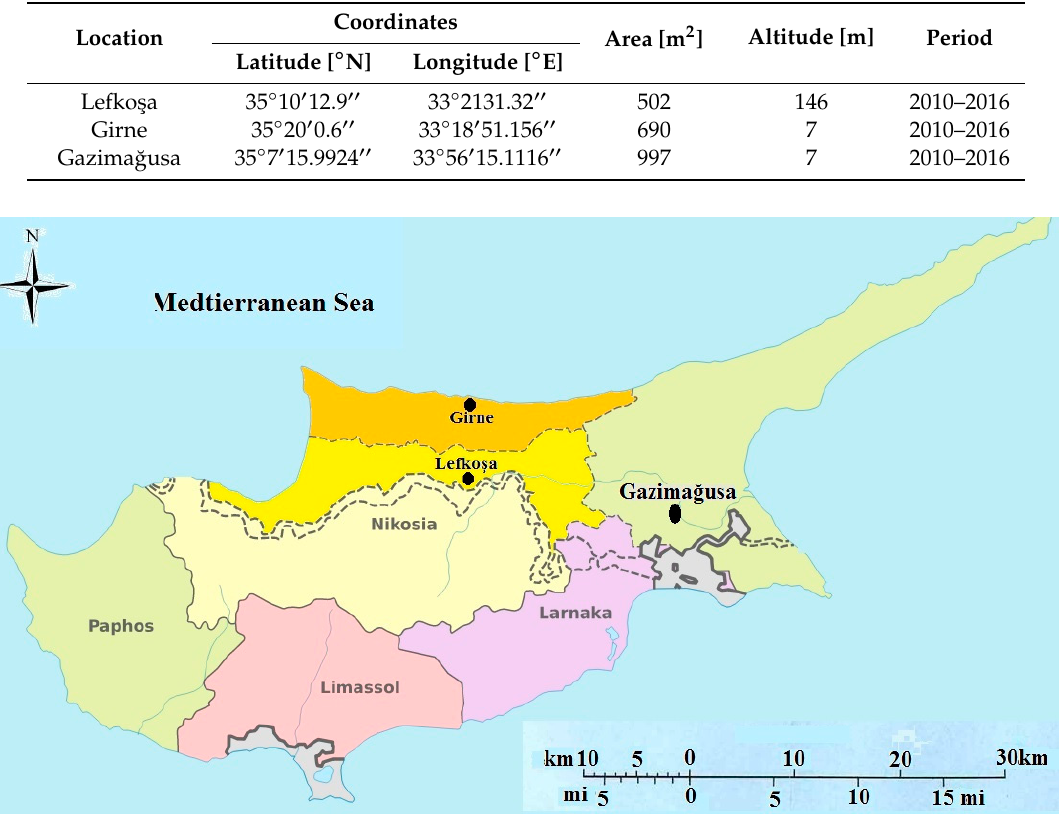
Figure 2. Locations of selected regions in the Northern part of Cyprus.